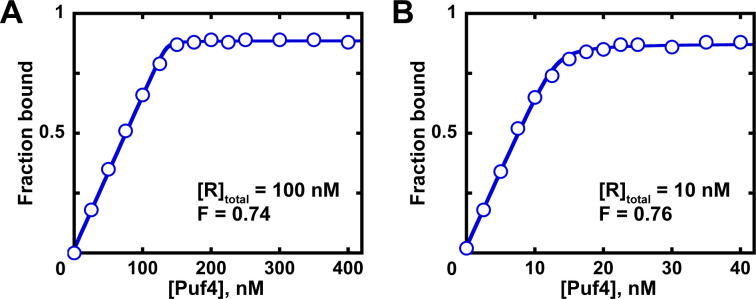
Determination of the fraction of active protein from a quadratic fit.Fits of titration data at 100 nM (A) and 10 nM (B) RNA to the quadratic equation are shown. The quadratic equilibrium-binding equation (Equation 5) was modified to include a term for the active protein fraction.(8)Fraction bound =A × ([R]total+ F× [P]total + KD) −([R]total+ F × [P]total + KD)2− 4 × [R]total × F × [P]total2 × [R]total+OA and O correspond to the amplitude and Y axis offset, respectively; F is the fraction of active protein; [R]total was constrained to the known RNA concentration (10 or 100 nM); here, the KD value was constrained to the known affinity (Table 2). The last constraint is optional, as the KD value contributes minimally to the fit at these high RNA concentrations and because the exact KD value may not yet be known at the time of measuring the active protein fraction. The fit fractions of active protein (F) are almost identical to those determined from linear fits of the same data in Figure 7 (~0.75).